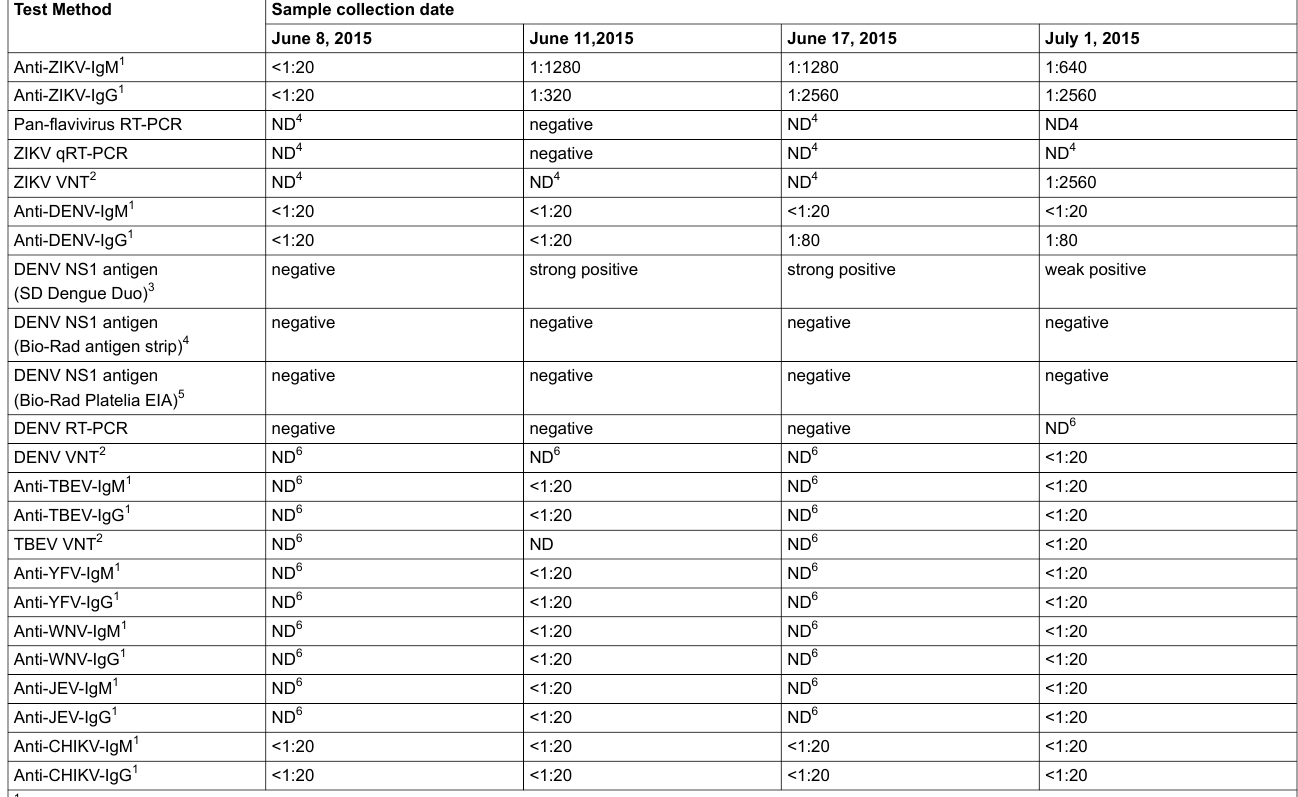
Table 1: Serological and virological data of a case of Zika virus imported from Brazil into Switzerland, June